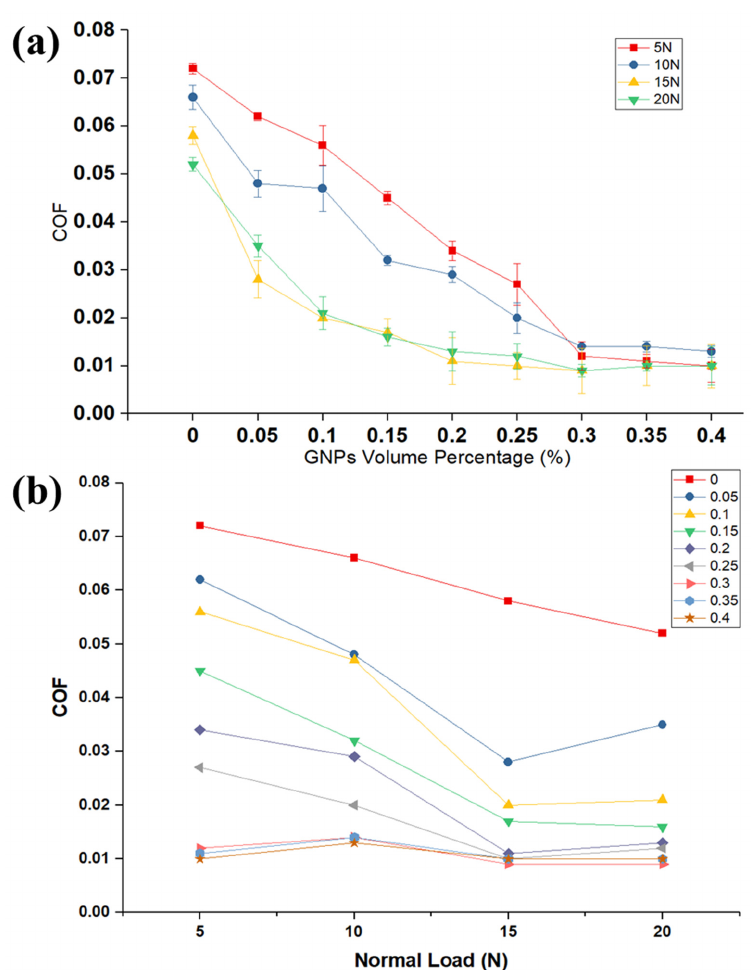
Figure 2. ( a ) Variation of the coefficient of friction with varying GNPs percentage in the oil at different loads. ( b ) The variation of coefficient of friction (COF) with different loads at several volume percentages of GNPs. Nanomaterials 2021 , 11 , x FOR PEER REVIEW